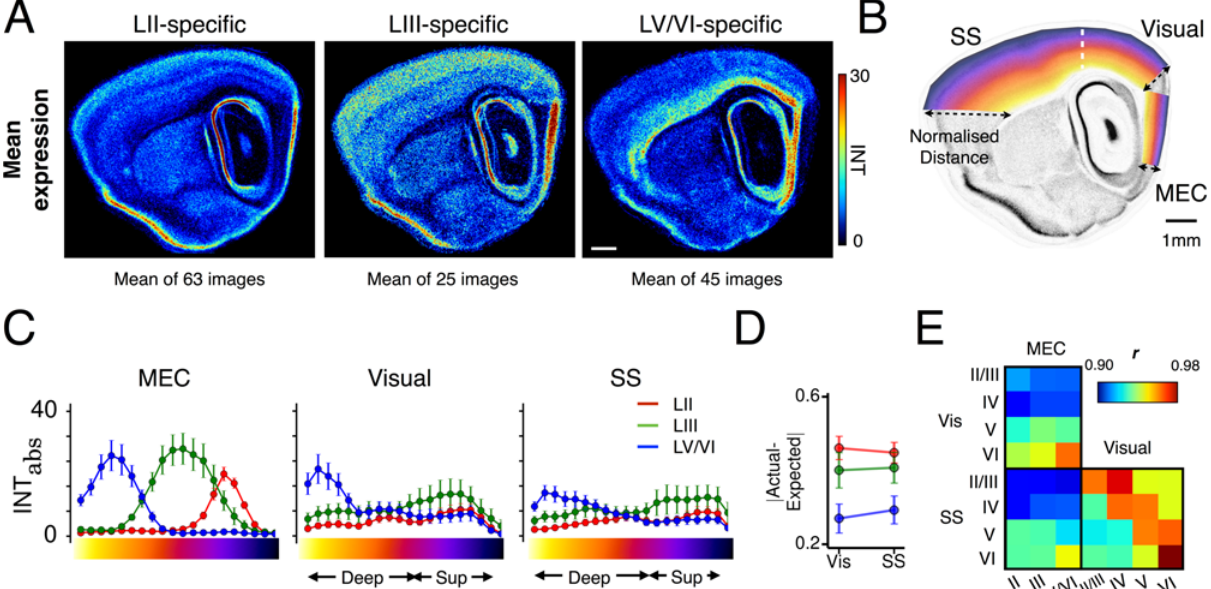
Figure 5. Molecular similarity between neocortex and MEC is greater for deep than superficial layers. (A) Mean expression patterns of layer-specific genes with images in the ABA re-registered data set corresponding to the central reference plane. Scale bar 1mm. (B) Schematic of the central reference image showing the MEC, visual and SS regions overlaid by a color-coded map representing the normalized distance from the inner white matter (0) to the brain surface (1). Pixel intensities were extracted from all locations and binned into 20 groups according to normalized distance. (C) Plots of the distribution of pixel intensities for each MEC layer-specific gene group (see (A)) as a function of distance from the inner white matter border. Error bars represent standard error of the mean. There is a main fixed effect of layer-specific group on neocortical expression (Mixed Model Analysis, F = 22, p < 0.001). Arrows indicate regions of deep and superficial (Sup) neocortex. Laminar boundaries were estimated using individual and mean expression profiles of MEC and SS layer- specific genes (S5 Fig.). (D) Genes with deep layer-specific expression in MEC show significantly more similar expression patterns in their equivalent neocortical layers than in superficial layers (MANOVA, Overall effect of layer-specific group: F (4,174) = 3.3, p = 0.012; Between-subjects effects of layer- specific group: Vis F = 6.7, p = 0.002; SS: F = 6.0, p = 0.004. Tukey ’ s HSD Vis: Deep < LII: p = 0.002; Deep vs. LIII: p = 0.051; SS Deep < LII: p = 0.04; Deep vs. LIII: p = 0.051). (E) Correlation matrix color represents the Pearson ’ s correlation coefficient ( r ) between mean pixel intensity (mINT) in particular layers of MEC, visual and SS cortices for all genes in the re-registered ABA data set.